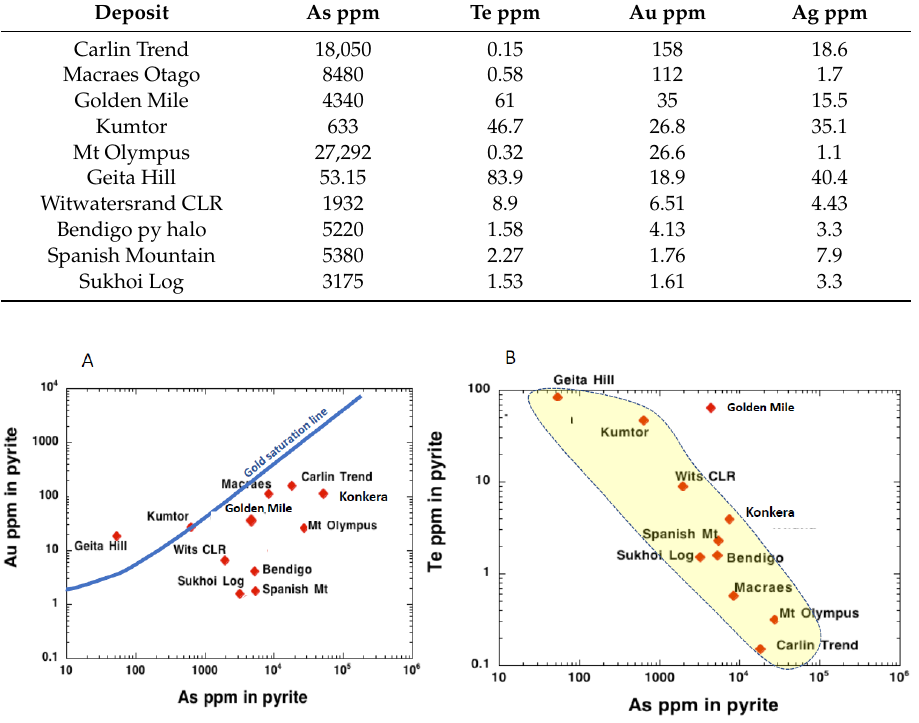
Figure 12. Mean values of Au, As and Te in pyrite from our LA-ICPMS analyses (Table 2) shown on a ( A ) Au-As plot, ( B ) As-Te plot.